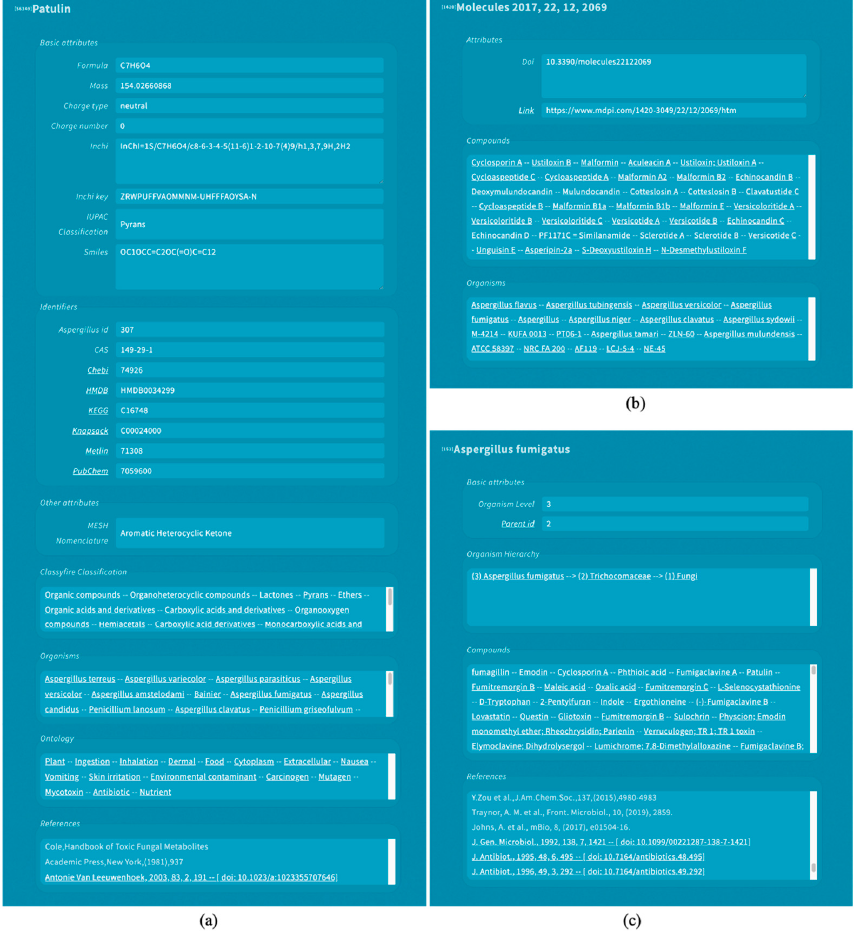
Table 2. Number of Aspergillus compounds in Aspergillus DB, NP Atlas, KNApSAcK, and A2MDB. AspergillusDB Figure 2. Web interface of CMM showing the information about ( a ) patulin compound; ( b ) literature reference with doi: 10.3390/molecules22122069; ( c ) Aspergillus fumigatus species.